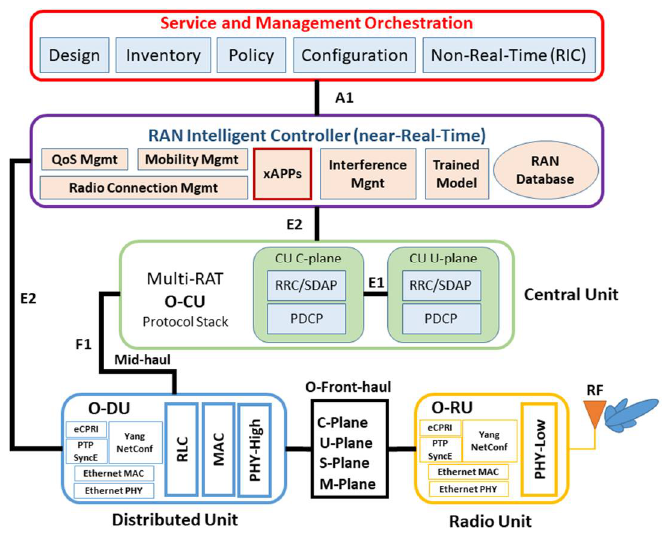
Figure 1. O-RAN architecture (base station disaggregation and openness).